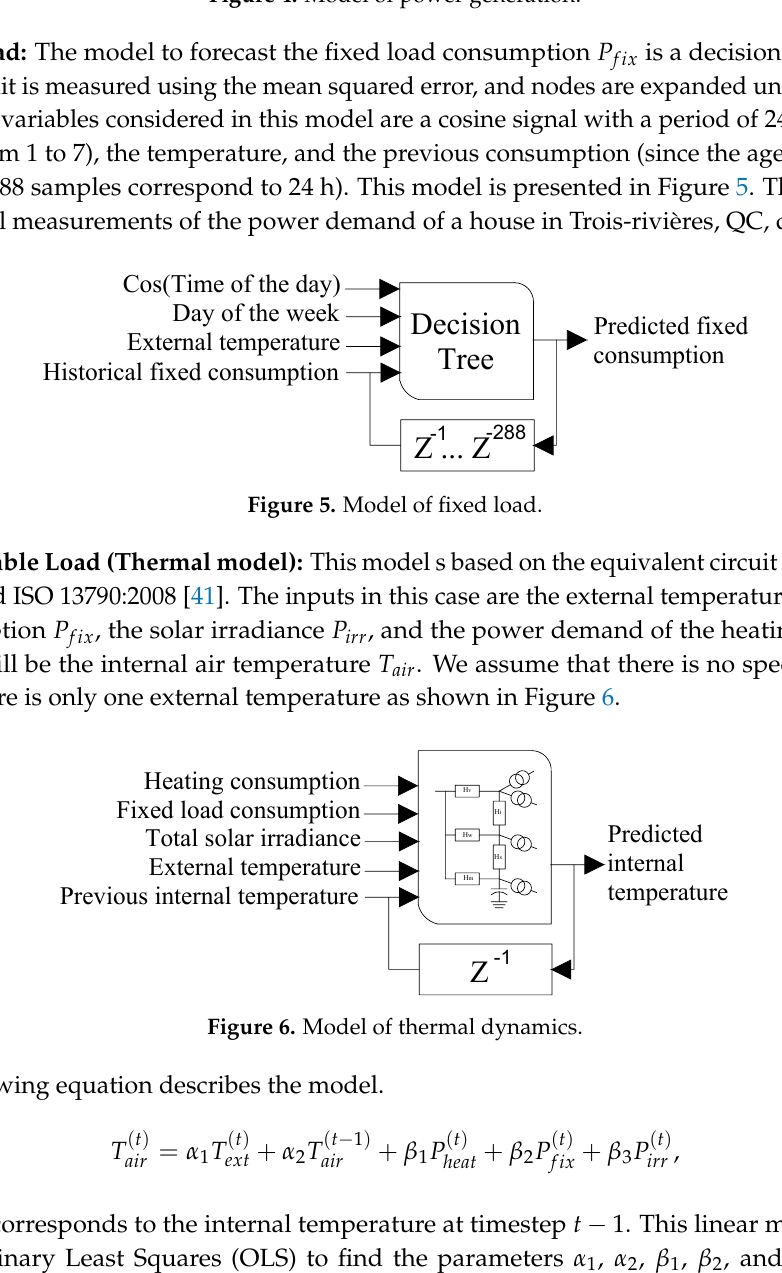
Figure 4. Model of power generation.